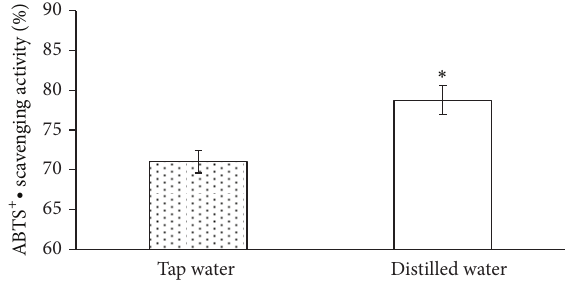
Figure 2: Effects of water solution on the reducing power of green tea.